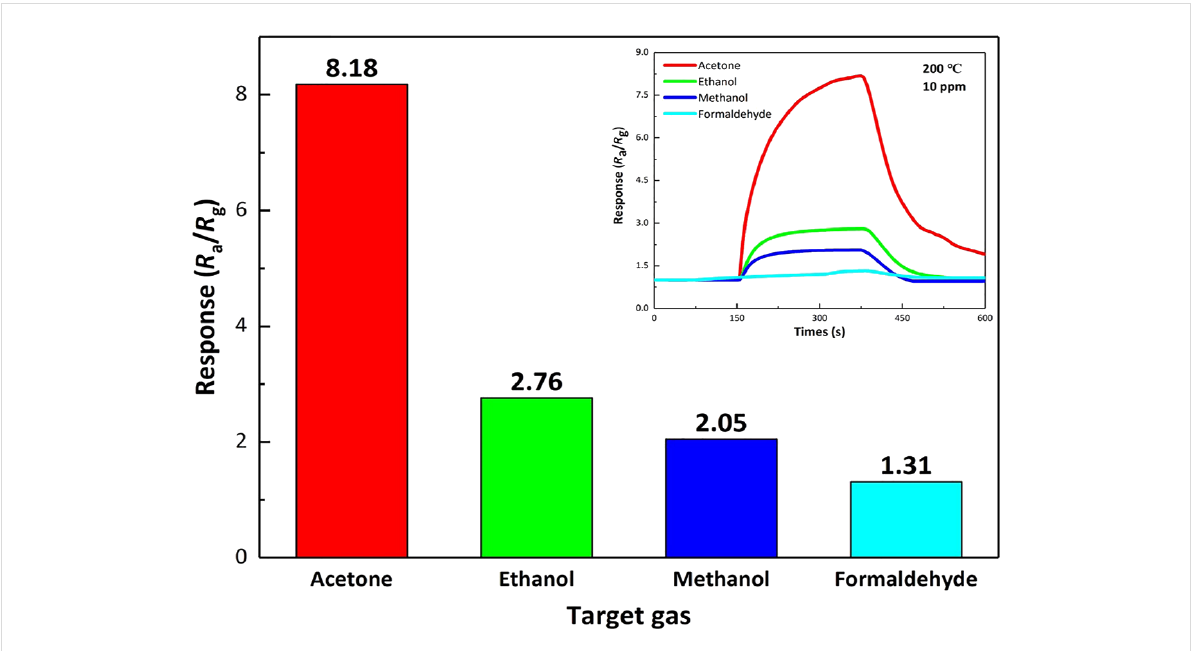
Figure 10: Response of the 0.5 wt % ZnFe 2 O 4 /rGO sensor to 10 ppm of acetone, ethanol, methanol and formaldehyde at 200 °C.